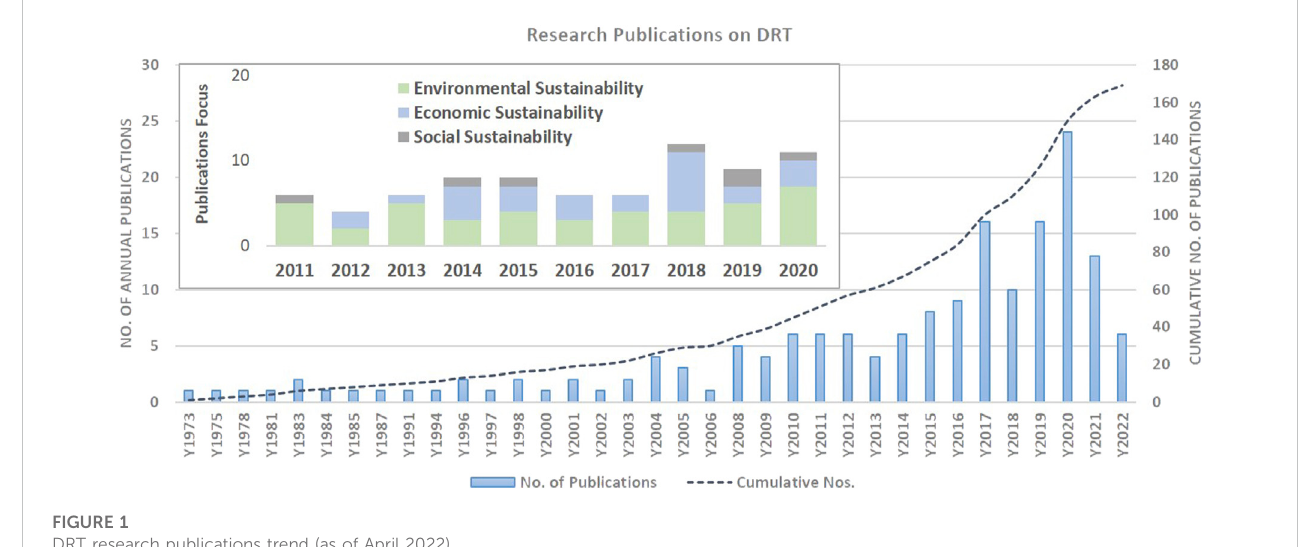
FIGURE 1 DRT research publications trend (as of April